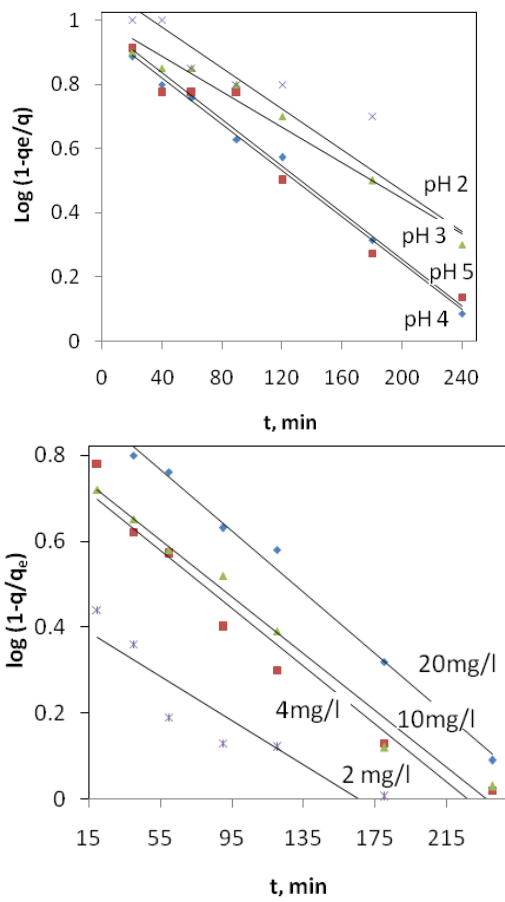
Fig.8. First-order kinetics plot for adsorption of Cu(II) on PSTM-3T at different pHs and at different initial concentrations.